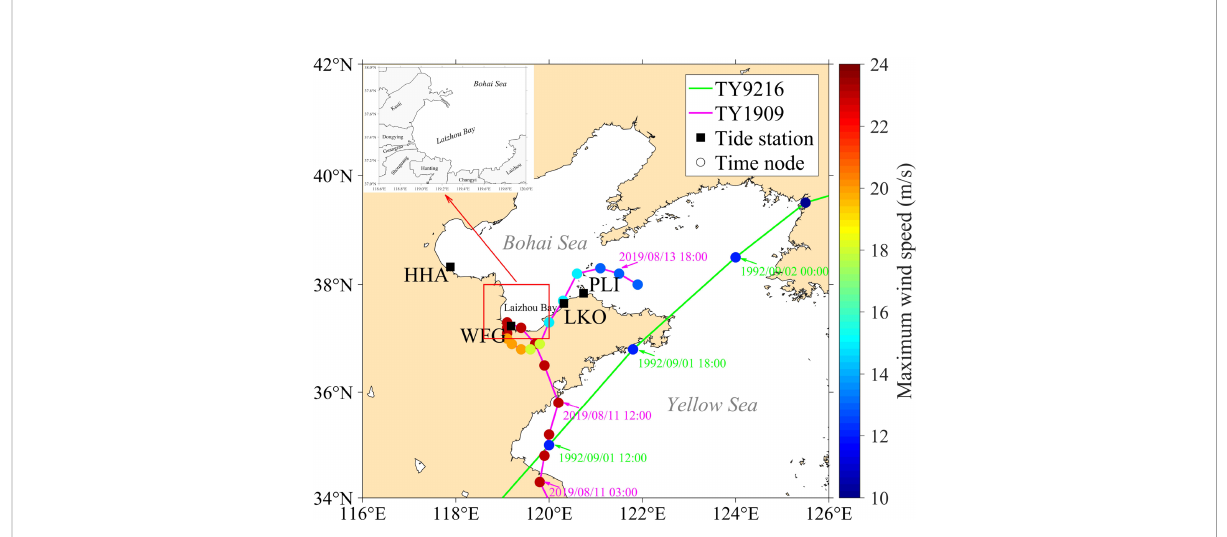
FIGURE 1 Track information of TY9216 and TY1909, the four tide station locations, the LZB location and the cities along the